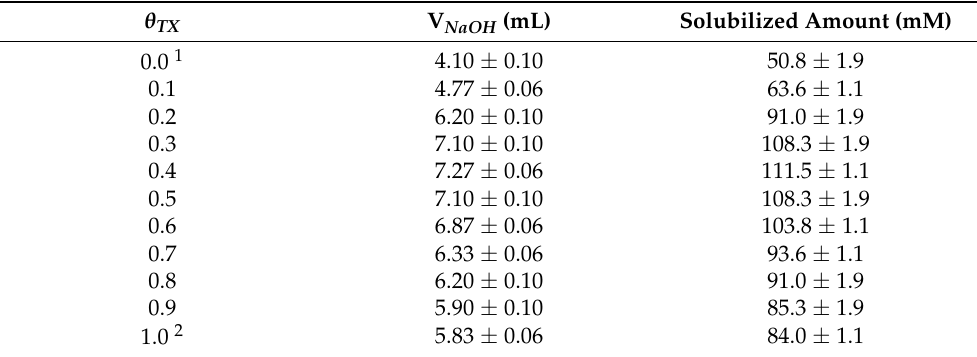
Table 2. Mixed micelles solubilized an amount of benzoic acid at whole composition ( θ TX ) range and 298 K temperature, determined by acid–base